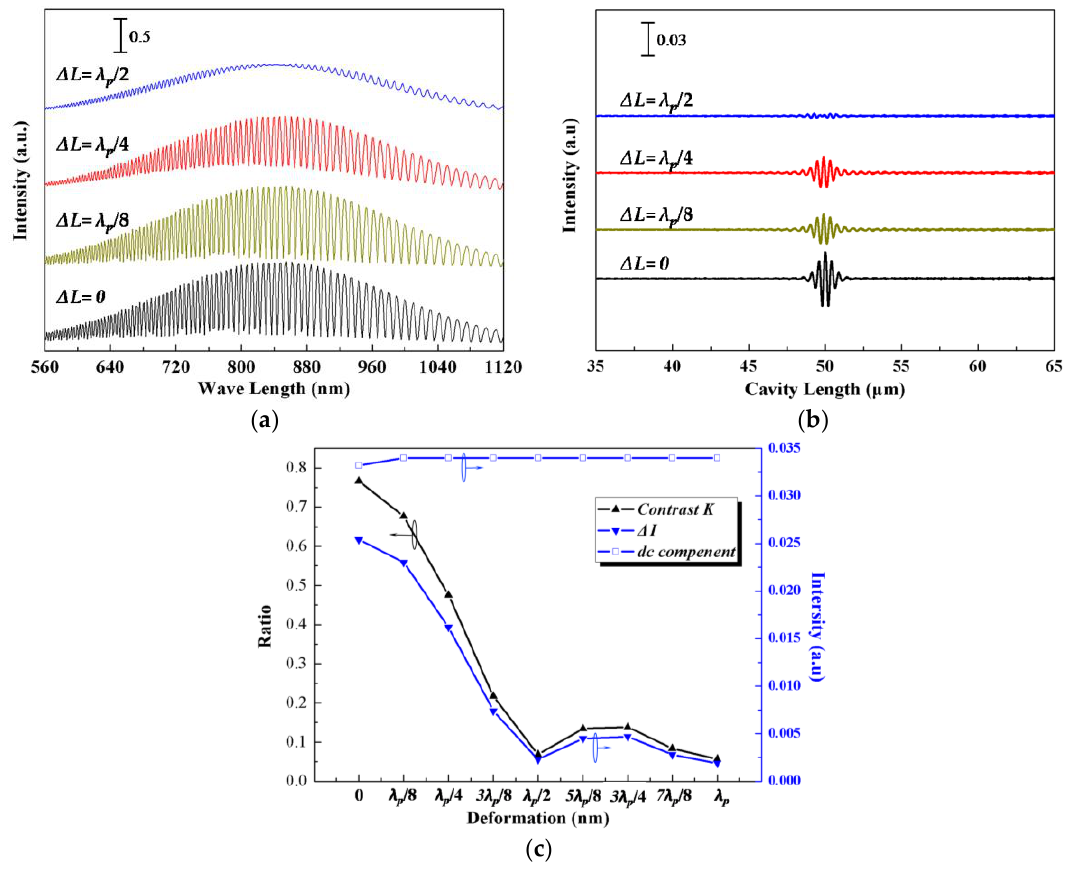
Figure 4. Simulated signals of fiber F-P sensor with different deformation: ( a ) F-P reflective light intensity; ( b ) demodulation signals; ( c ) contrast K , Δ I , dc component.